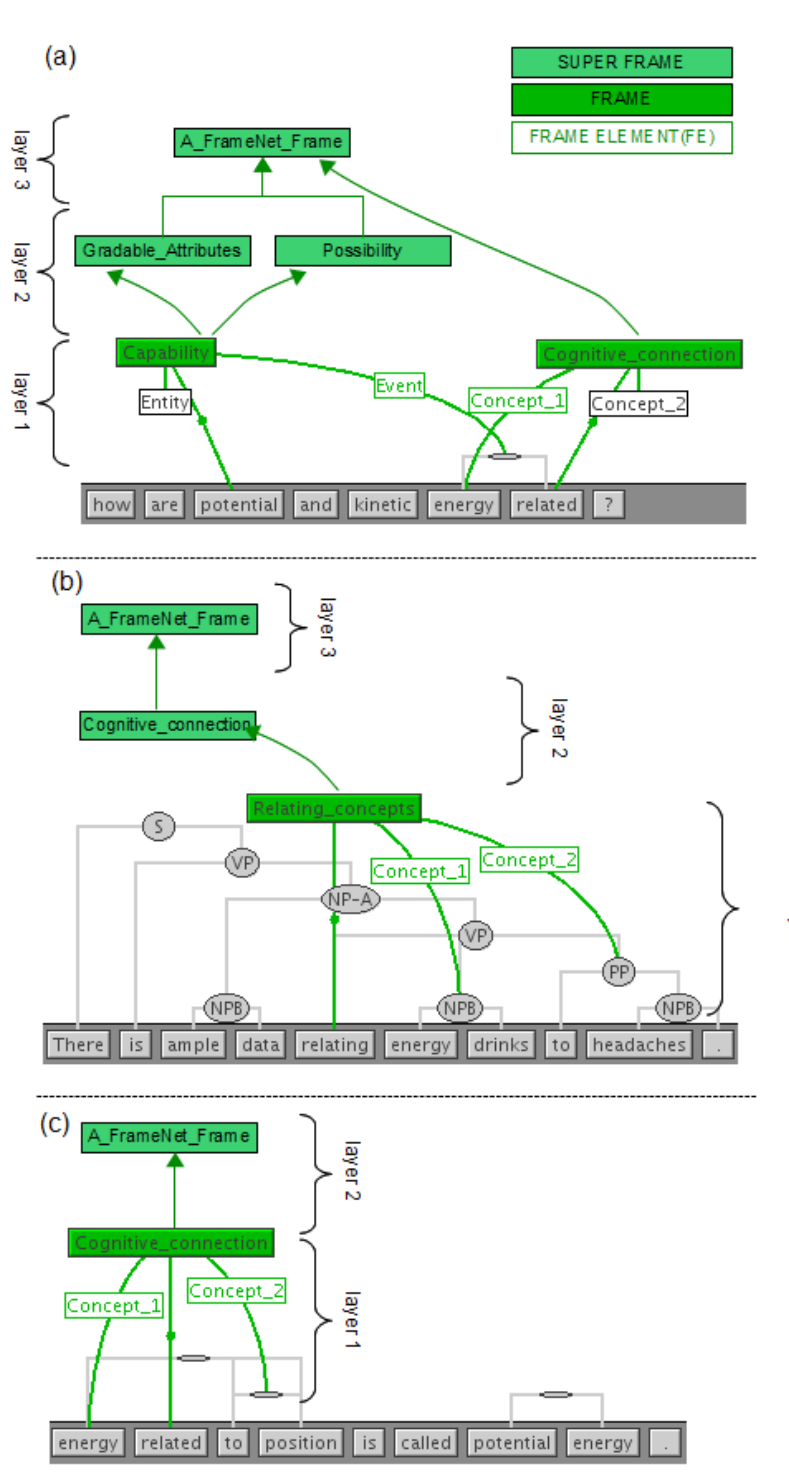
Figure 10 . FrameNet semantic role labeling of query (a) and candidate answers (b),